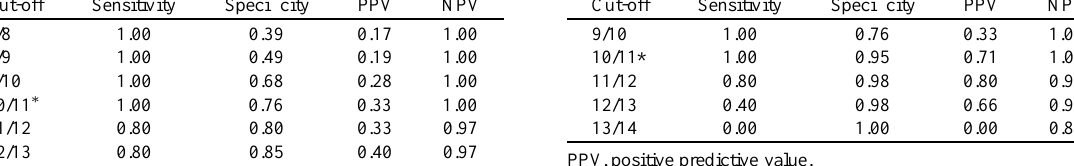
Table 4 Sensitivity, specificity, positive and negative predictive values at dif- ferent cut-off scores for the Hospital Anxiety and Depression Scale